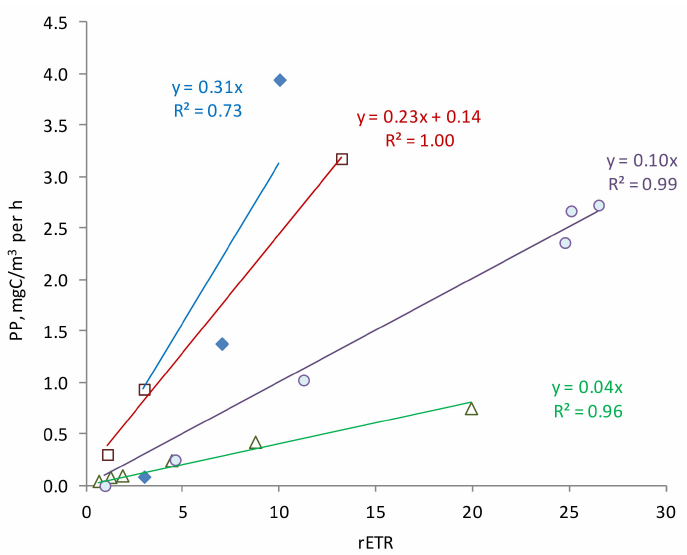
Figure 8. Relationship between primary production, PP, and relative electron transport rate, rETR, in the euphotic zone for April (circles), June (rhombus), October (squares), and November (triangle). The equation and determination coefficient of the regression are indicated on each regression